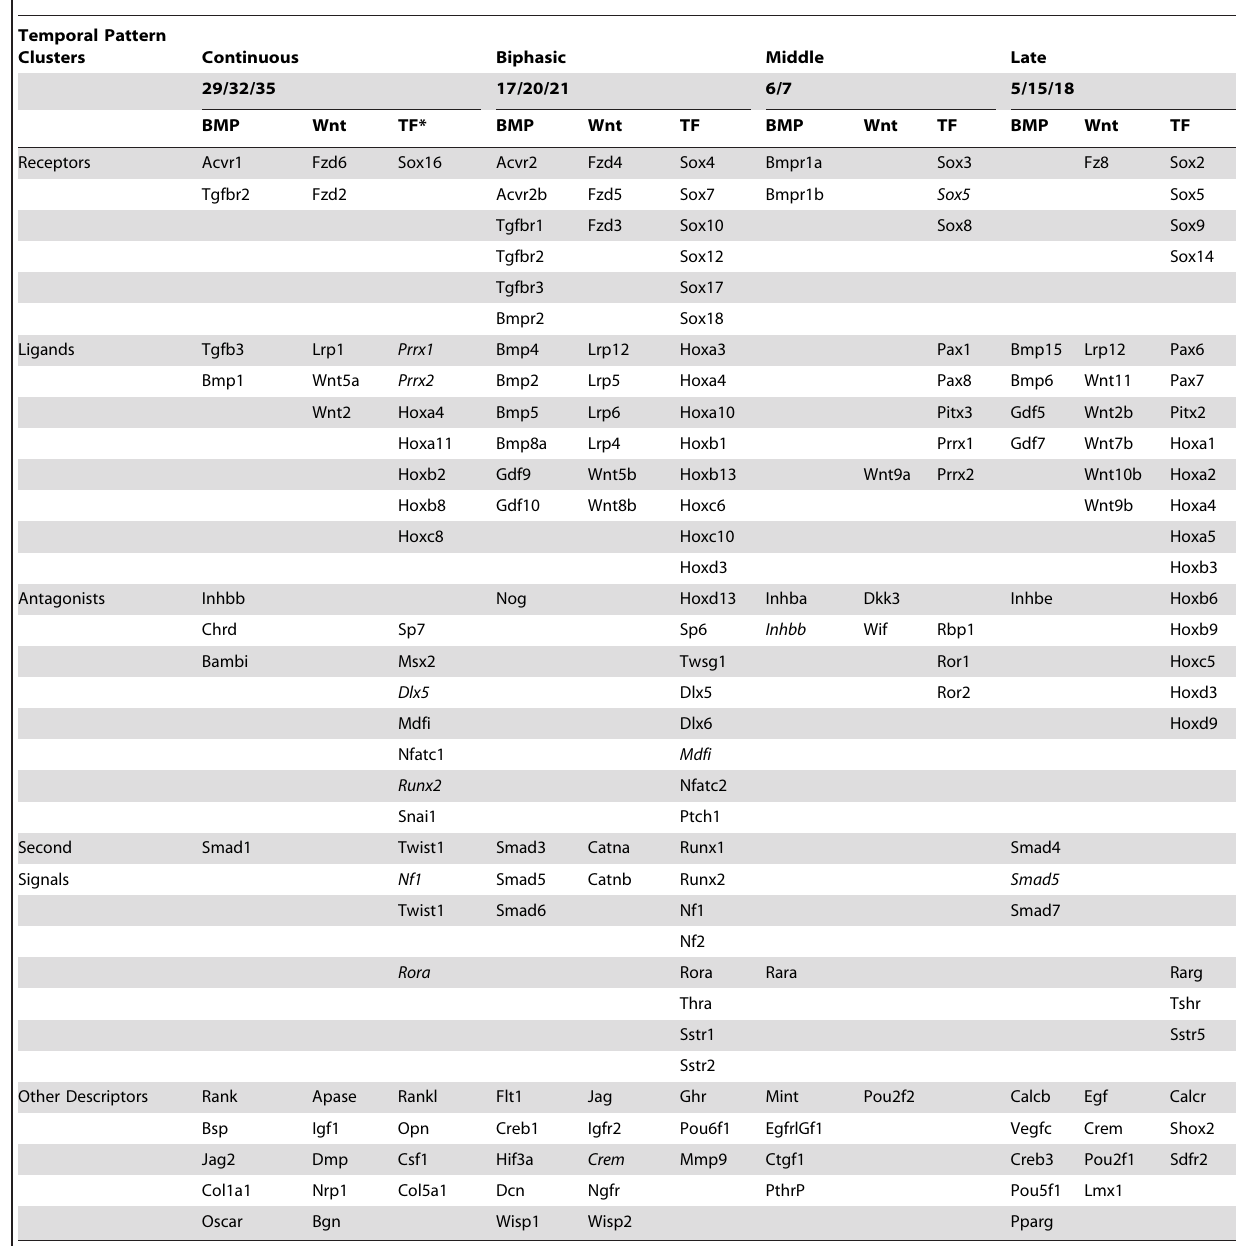
Table 3. TGF b and Wnt Families of Expressed Ligands Receptors, Antagonists, Second Signals, and Transcription Factors